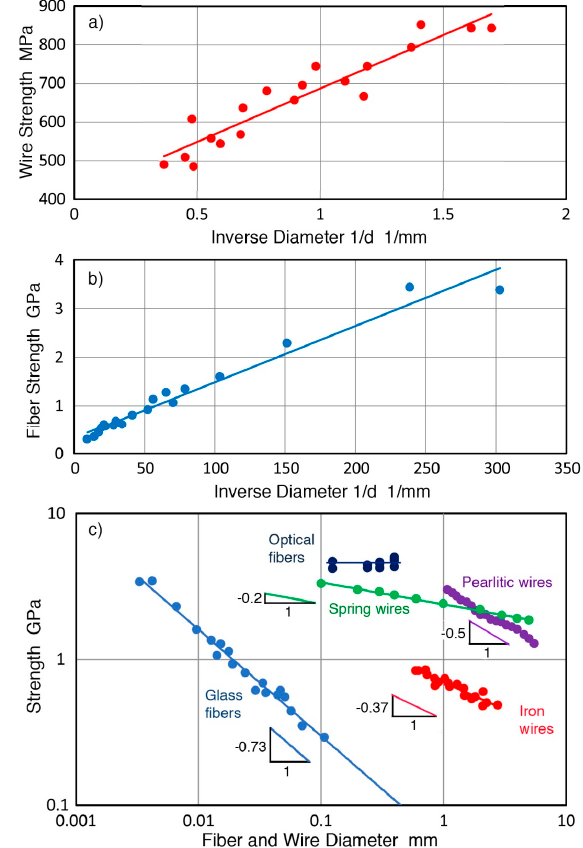
Figure 1. Strength versus diameter of fibers or wires. ( a ) Dufour and Seguin brothers’ data (1824) from [9]. ( b ) Griffith glass fiber data (1921) from [14]. ( c ) Log-log plots of five data sets as indicated data from [4,9,14-16]. See text.